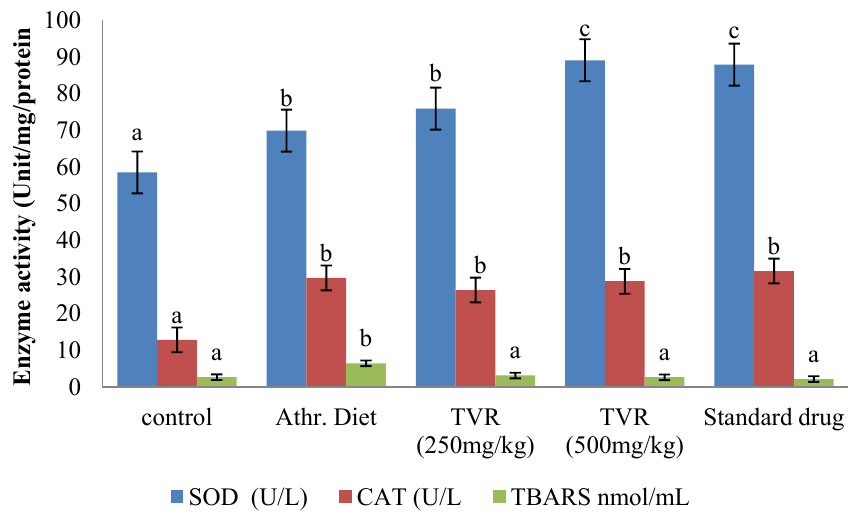
Figure 2. Effect of various doses of TVR on activity of tissue antioxidant enzymes in liver of diet-induced atherogenic rats. Mean values with the same letter subscripts within the different group are not significantly different ( p <